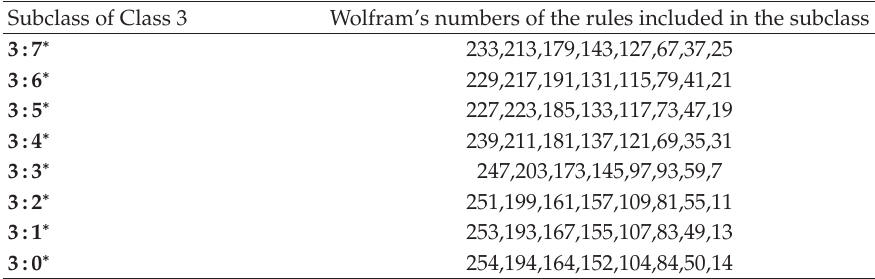
Table 5: Subclassification of Class 3